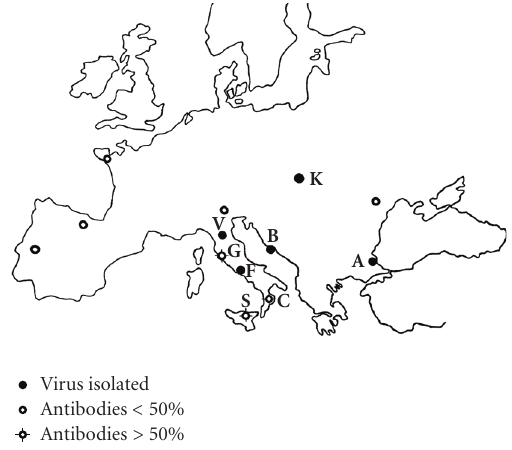
Figure 2: Bhanja virus in Europe at the time of the study start: dot: BHAV isolated; circle with four short lines: antibody positivity ≥ 50% of domestic ruminants; circle: seropositivity < 50%. The letters indicate the selected foci; for their abbreviations see Section 2.